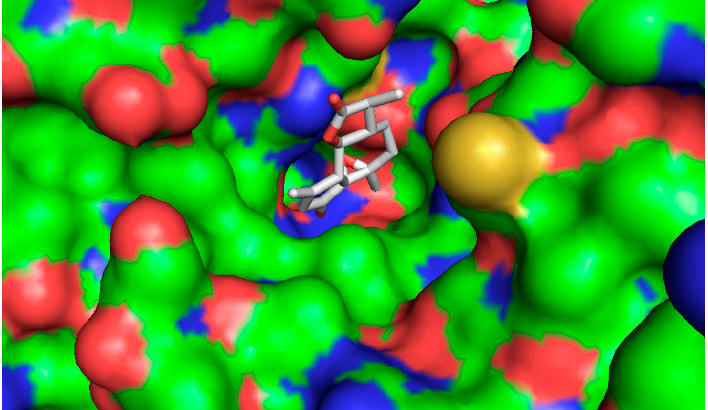
Figure 10. Bound conformer of ligands interacting with the substrate binding sites of HMGR for 1 β ,10 β -epoxydesacetoxymatricarin (CP1).